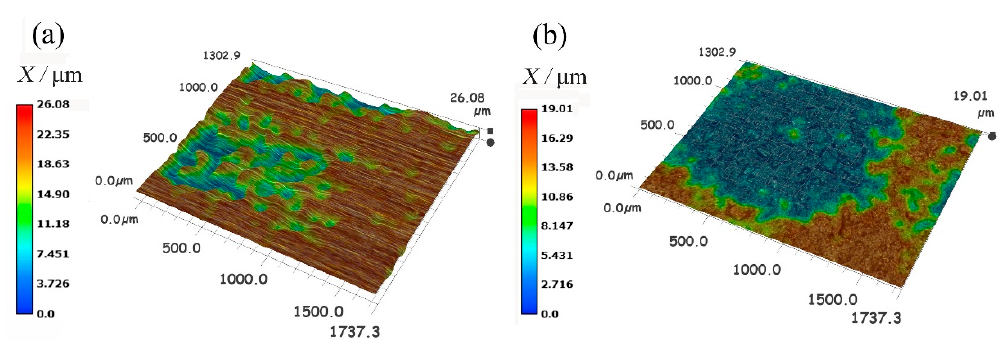
Figure 6. 3D surface profile of ( a ) as-received steel and ( b ) aluminized steel.